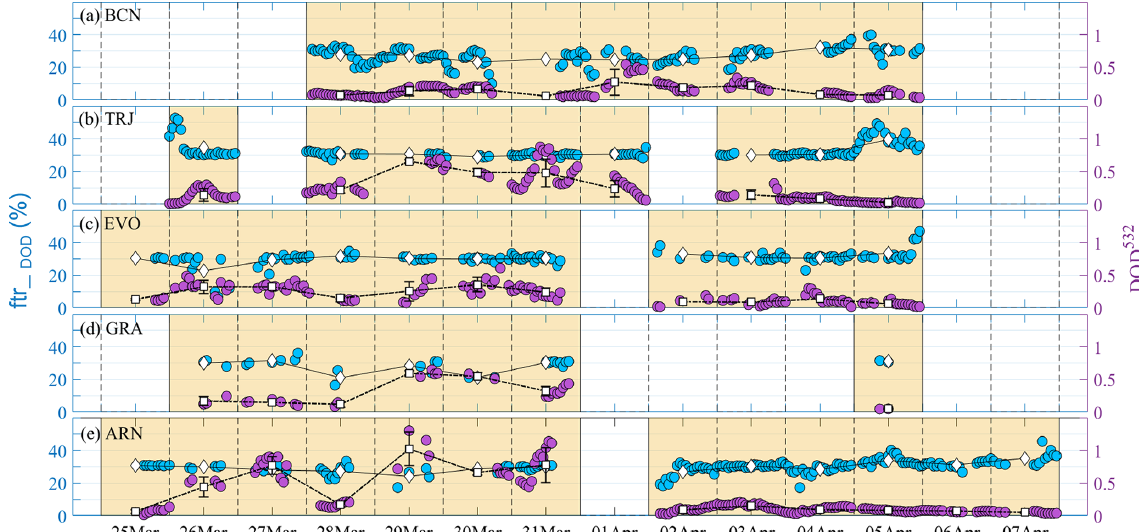
Figure 5. Temporal evolution of the total dust (DD) optical depth at 532nm (DOD 532 ) (right axis, in purple), and its fine to total ratio (ftr_ DOD %) (left axis, in blue), over the five Iberian lidar stations as latitude decreases (from up to down panels): (a) BCN, (b) TRJ, (c) EVO, (d) GRA, and (e) ARN. Circles indicate hourly averages. Diamonds and squares indicate daily averages for ftr_ DOD and DOD 532 ,